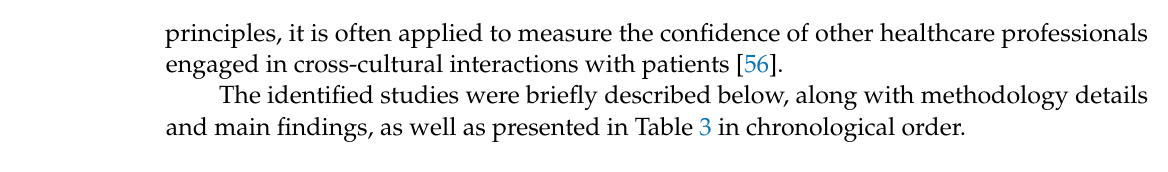
Table 3. Descriptive summary of studies on nursing